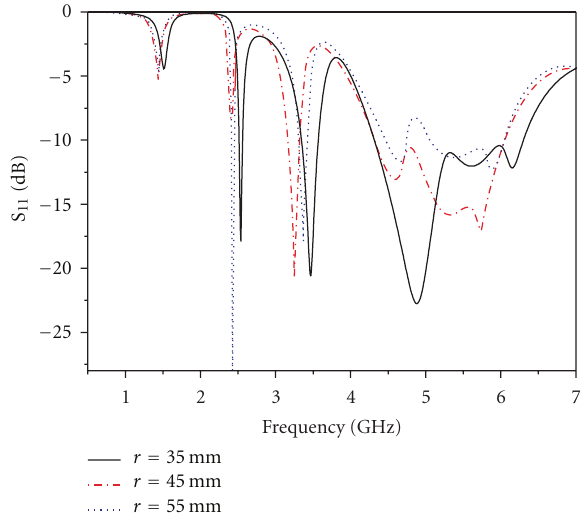
Figure 5: S 11 results of the proposed antenna in terms of the radius of